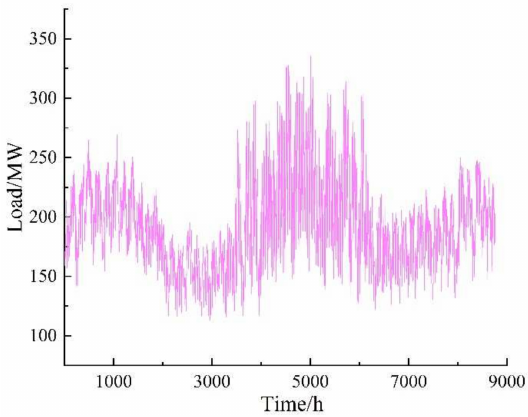
Figure 10. Full year load forecast curve.